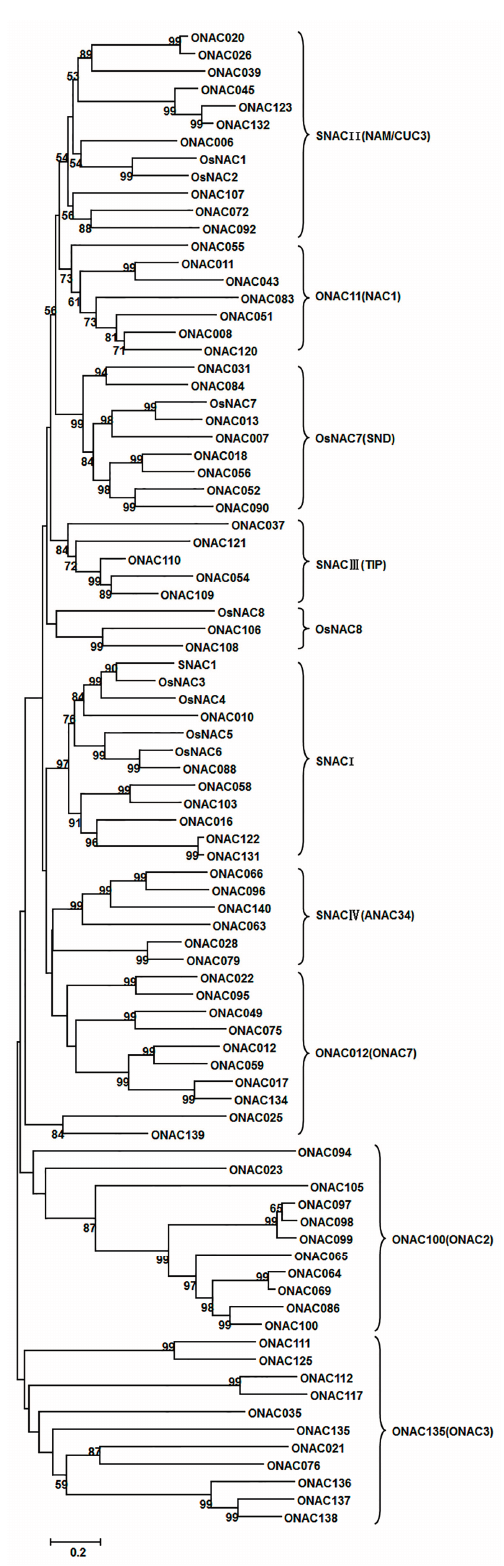
Figure 6. Uprooted phylogenetic tree representing relationships among stress-responsive ONAC genes. Full-length protein sequences of 86 ONAC genes (63 ONAC genes showing overlapping expression patterns, several previously reported ONAC genes, and some homologous ONAC genes) were used for multiple alignments by the clustalw2 program and a phylogenic tree was created and visualized using MEGA